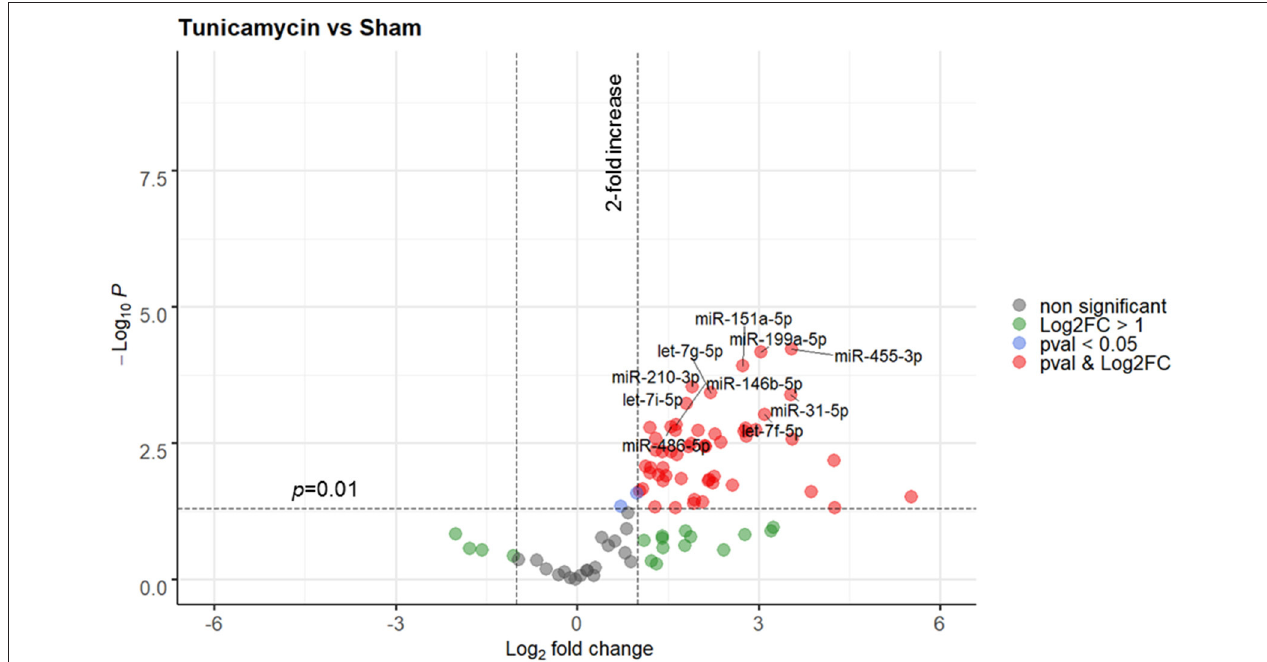
FIGURE 3 | Volcano plot depicting the Log 2 -transformed fold change (LogFC, x-axis) of circulating miRNAs induced by tunicamycin compared to controls (sham) in relation to their p value [ − Log10 (pval), y-axis]. The 10 most significantly regulated miRNAs (lowest pval) by tunicamycin are labeled. Sham group ( n = 4 animals); Tunicamycin group ( n = 3 animals).